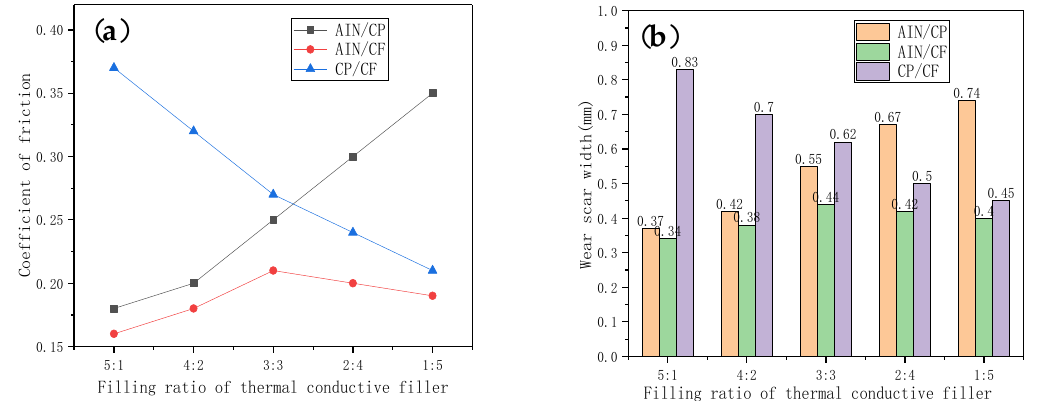
Figure 8. Friction and wear performance of binary TSGs with different thermal conductivity filler ratios. ( a ) Friction coefficient. ( b ) Width of wear scar.